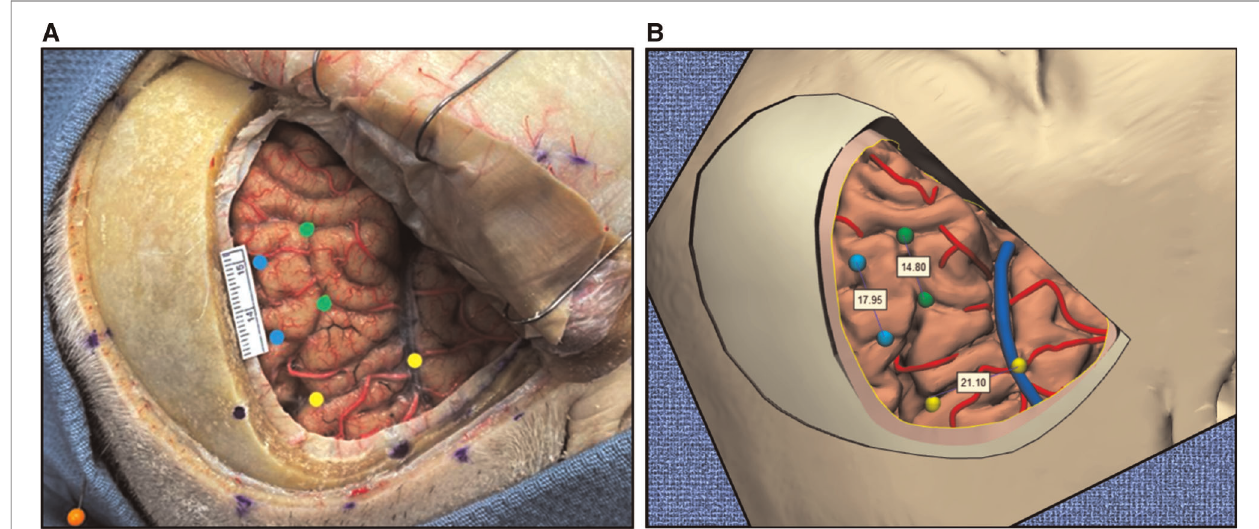
FIGURE 6 | Measurements in the real-world setting using a photograph ( A ) correspond to the 3D virtual model ( B ). Ruler and values shown are millimeters. Used with permission from Barrow Neurological Institute, Phoenix, Arizona